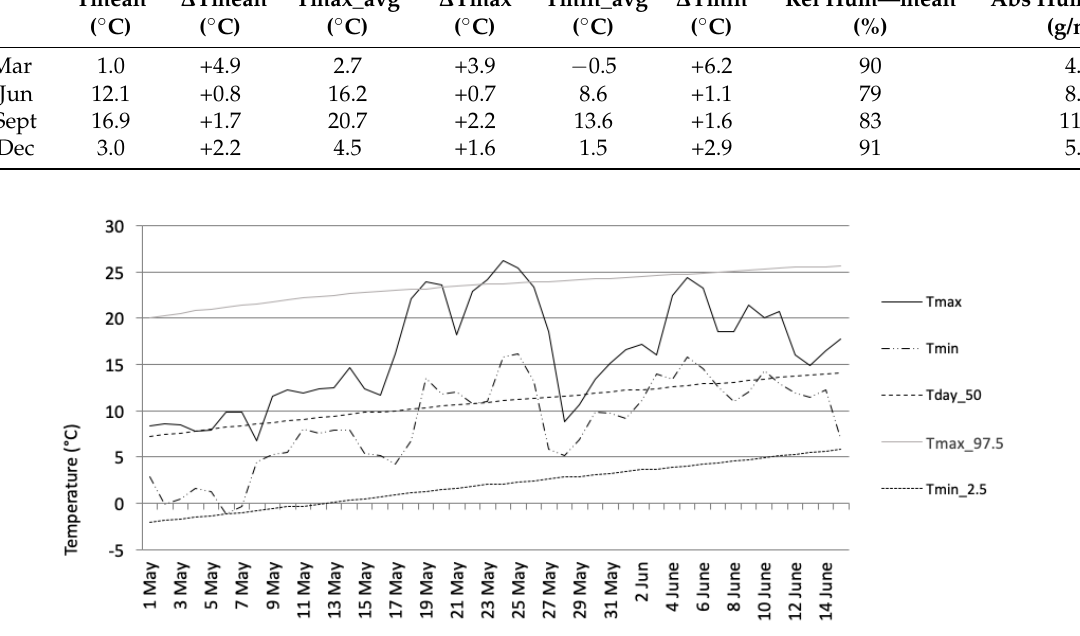
Figure 1. Daily maximum and minimum temperatures at Helsinki–Kaisaniemi during the second survey period (May). Tmax = maximum temperature, Tmin = minimum temperature, Tday_50 = 50th percentile of daily mean temperature distribution, Tmax_97.5 = threshold for exceptionally high temperatures (or the 97.5 percentile of the daily maximum temperature distribution), Tmin_2.5 = threshold for exceptionally low temperatures (or the 2.5 percentile of daily minimum temperature). The percentiles were determined for the normal climate period from 1981 to